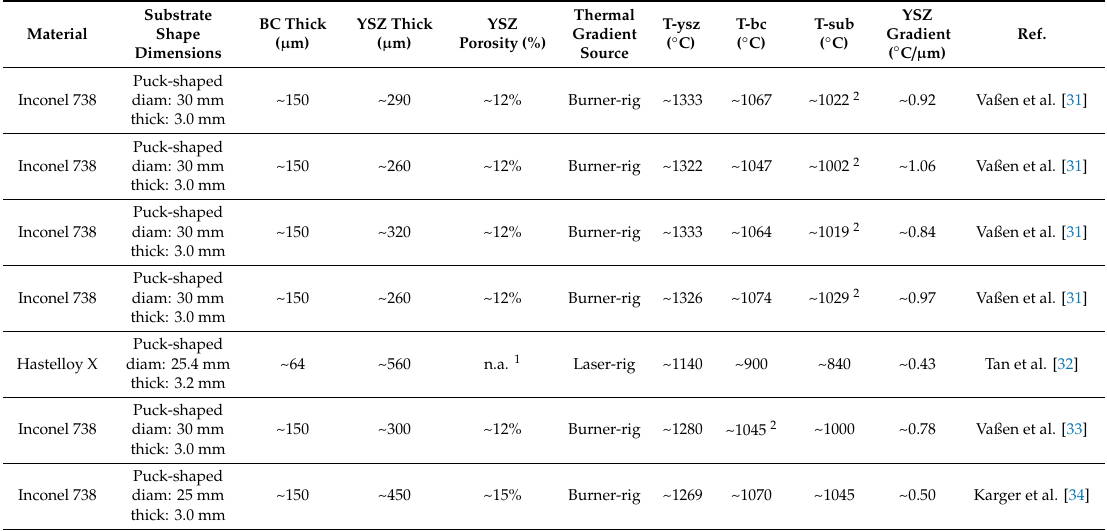
Table 3. Summary of thermal gradient values for porous APS YSZ TBCs reported in the literature.